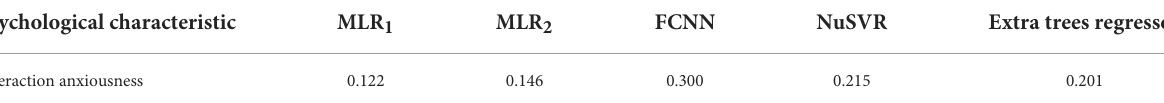
TABLE 3 Criterion validity of interaction anxiousness